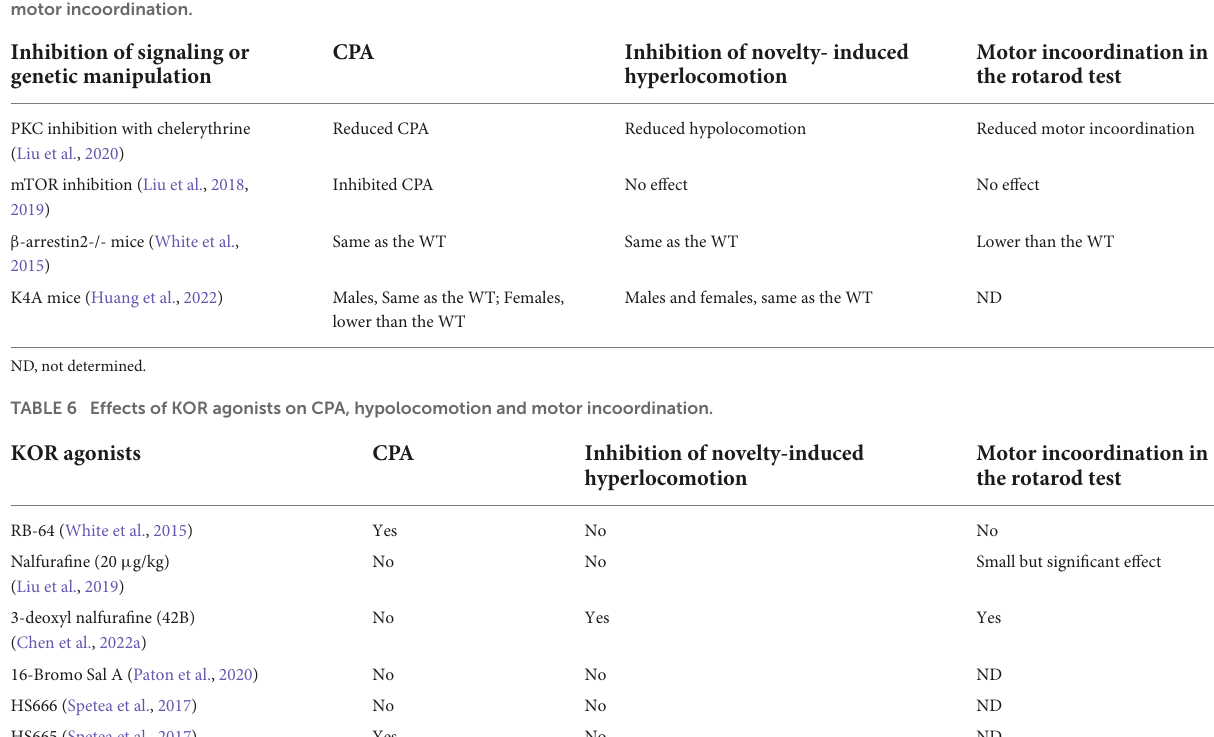
ND No (in the hole-board test)